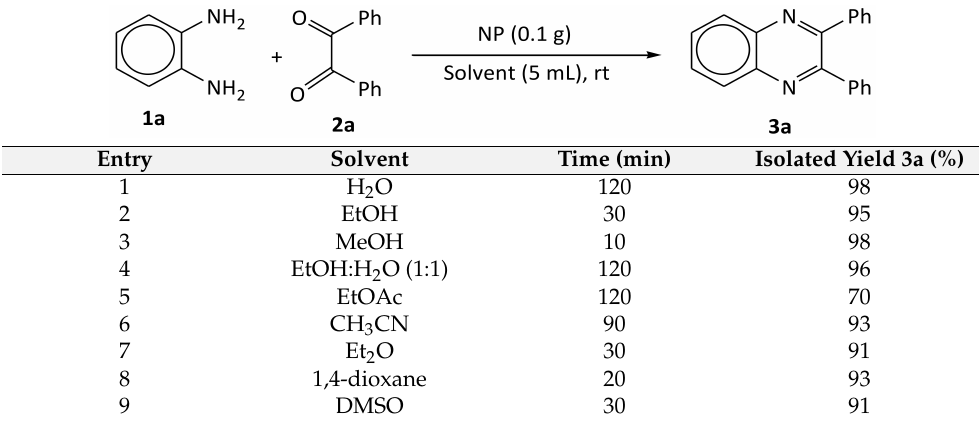
Table 3. Effect of various solvents on the synthesis of 3a by using NP as the